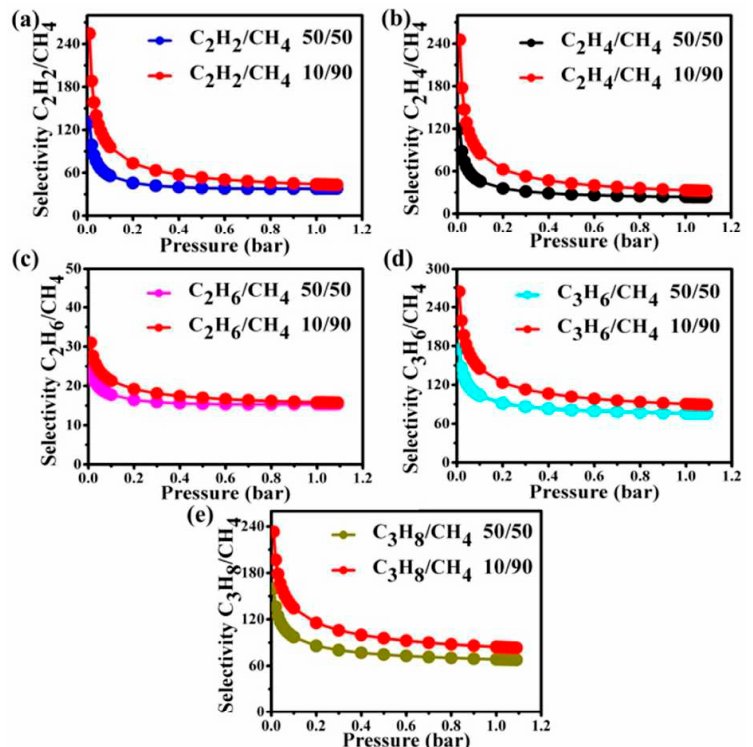
Figure 7. Selective adsorption of UPC-21. The calculations of the ideal adsorbed solution theory (IAST) selectivities for mixtures of C 2 H 2 /CH 4 ( a ); C 2 H 4 /CH 4 ( b ); C 2 H 6 /CH 4 ( c ); C 3 H 6 /CH 4 ( d ); C 3 H 8 /CH 4 ( e ) at